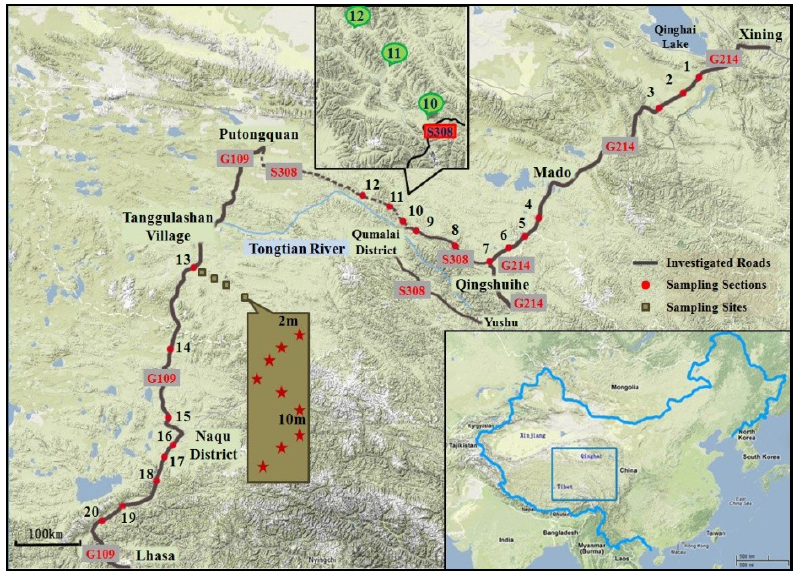
Figure 1. Location of the three roads and sampling sites.